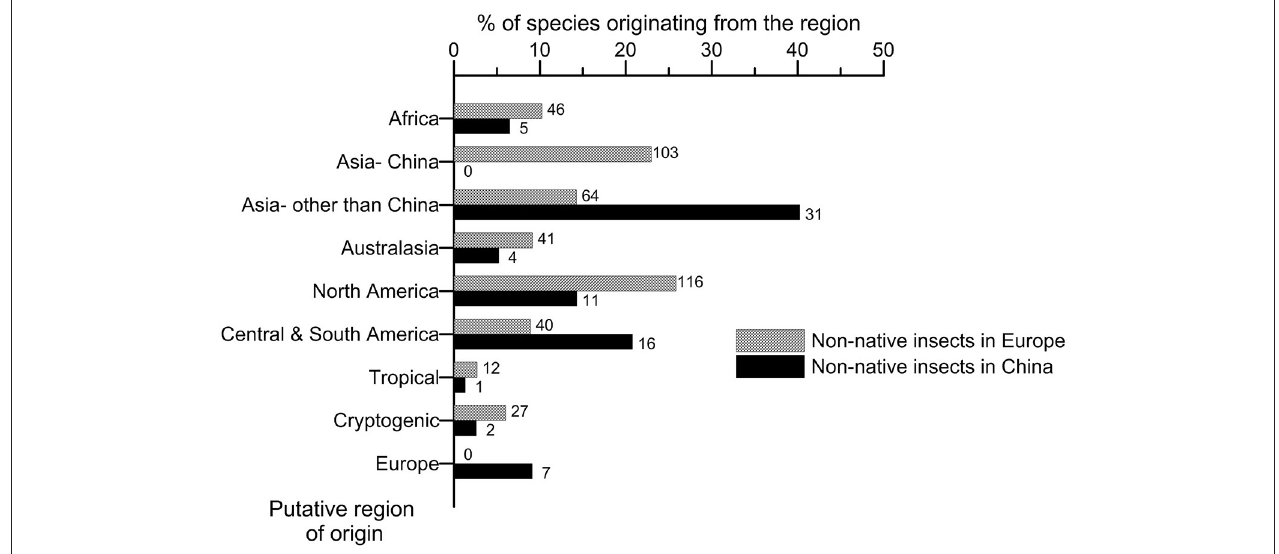
FIGURE 2 | Comparison of the regions of origin of the non-native species associated to woody plants having established in Europe and China up to 2019. The number on the right of each bar indicates the total number of non-native species observed per region of origin.